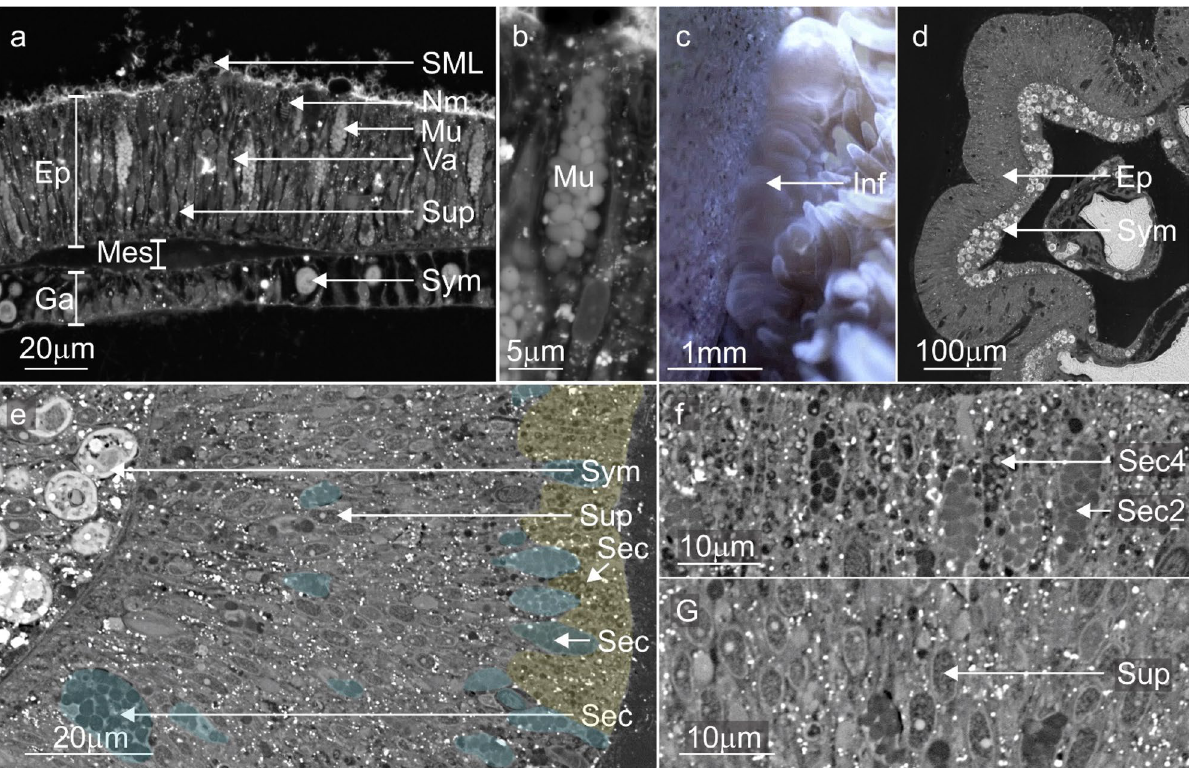
Figure 4. Backscatter electron microscopy images and stills from time-lapse movies comparing A. millepora’ ’s regular SBW with the enlarged tissues during the contact response phase. ( a ) A standard surface body wall (SBW) of A. millepora showing the two epithelial layers (epidermis; Ep, gastrodermis; Ga) separated by the mesoglea (Mes) and the cells and processes that characterise these layers; supporting cells (Sup), intercellular vacuole (Va) or spaces in between each cell, nematocysts (Nm), type 2 gland cell (Mu), Symbiodiniaceae (Sym) and the soluble surface mucus layer (SML). ( b ) Higher magnification image of the vesicles (white) in standard type 2 gland cells (mucocytes). ( c , d ) The soft tissue became enlarged at the points of contact between the coral and the substrate. ( d ) Electron microscopy images of the enlarged SBW tissues showed a proliferation of densely packed thin supporting cells and Symbiodiniaceae. and the differentiation/proliferation of type 4 (yellow) and type 1 and 2 (blue) gland cells (Sec) with lead to the loss of intercellular vacuoles. ( e , f ) Electron image showing the vesicles (Sec4) of type 4 gland cells with matter trapped inside and mucocytes (Sec2). ( g ) Closer look at the densely packed epitheliomuscular supporting cells (Sup) and their nuclei. Skeleton; Sk, surface body wall; SBW, epidermis; Ep, gastrodermis; Ga, mesoglea; Mes, surface mucus layer; SML, Nm; nematocyst, supporting cells; Sup, intercellular vacuole; Va, secretory cells; Sec, type 2 gland cell; Mu and Sec2, type 4 gland cell; Sec4, Symbiodiniaceae;